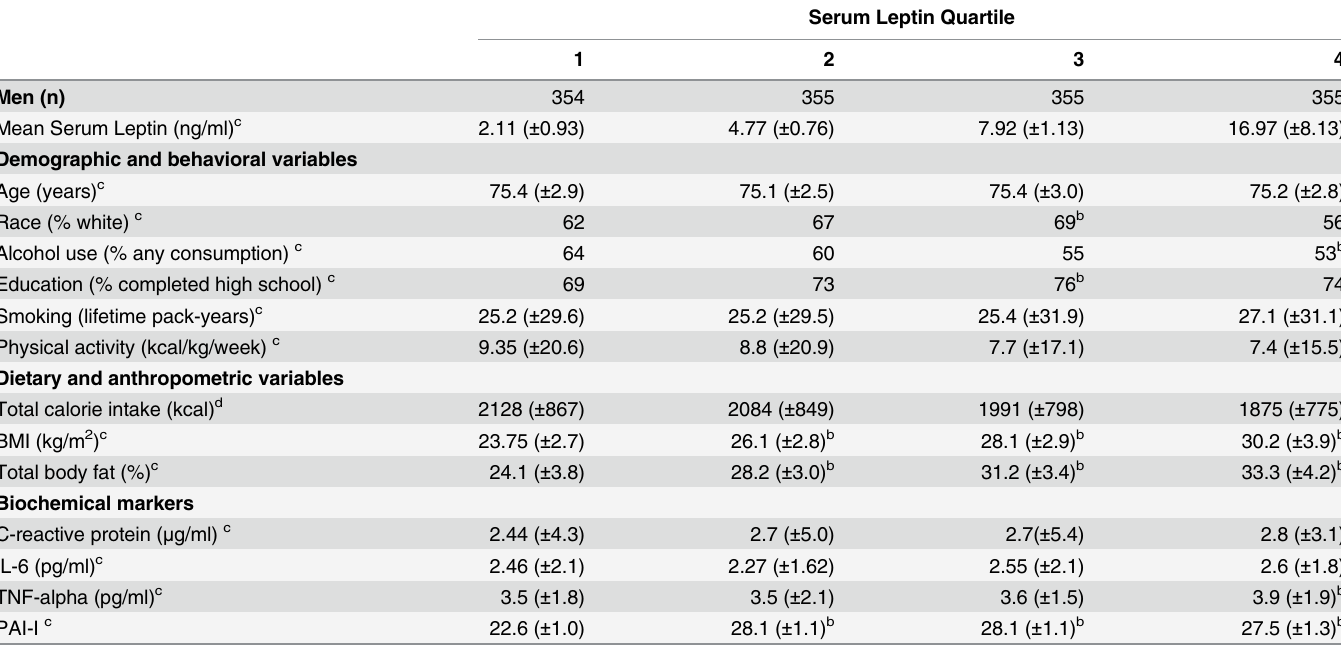
Table 1. Baseline characteristics of men by serum leptin quartile a